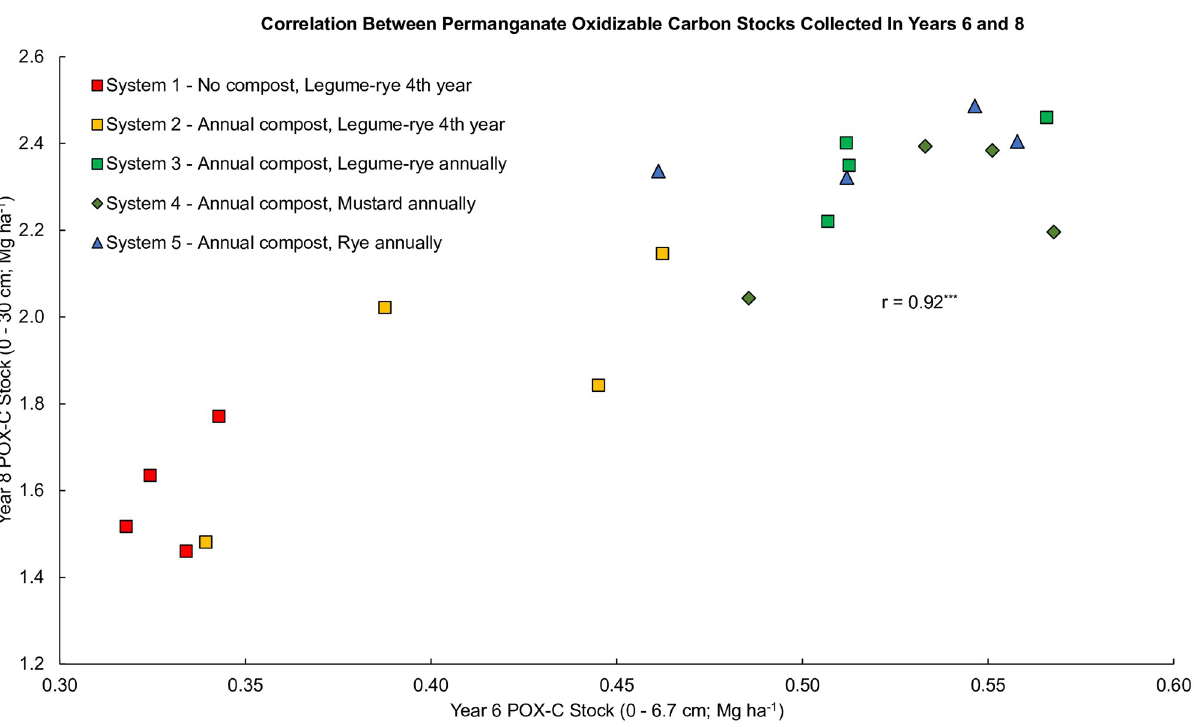
Fig 9. Correlation between permanganate oxidizable carbon stocks collected in years 6 and 8. Measurements were taken at the 0 to 6.7 cm depth in year 6 and at the 0 to 30 cm depth in year 8 in five organic vegetable systems in Salinas, CA. Systems differed by annual compost additions (0 vs. 7.6 Mg ha -1 before each vegetable crop), cover crop type (legume-rye, mustard or cereal rye alone) and cover cropping frequency (quadrennially vs. annually planted).